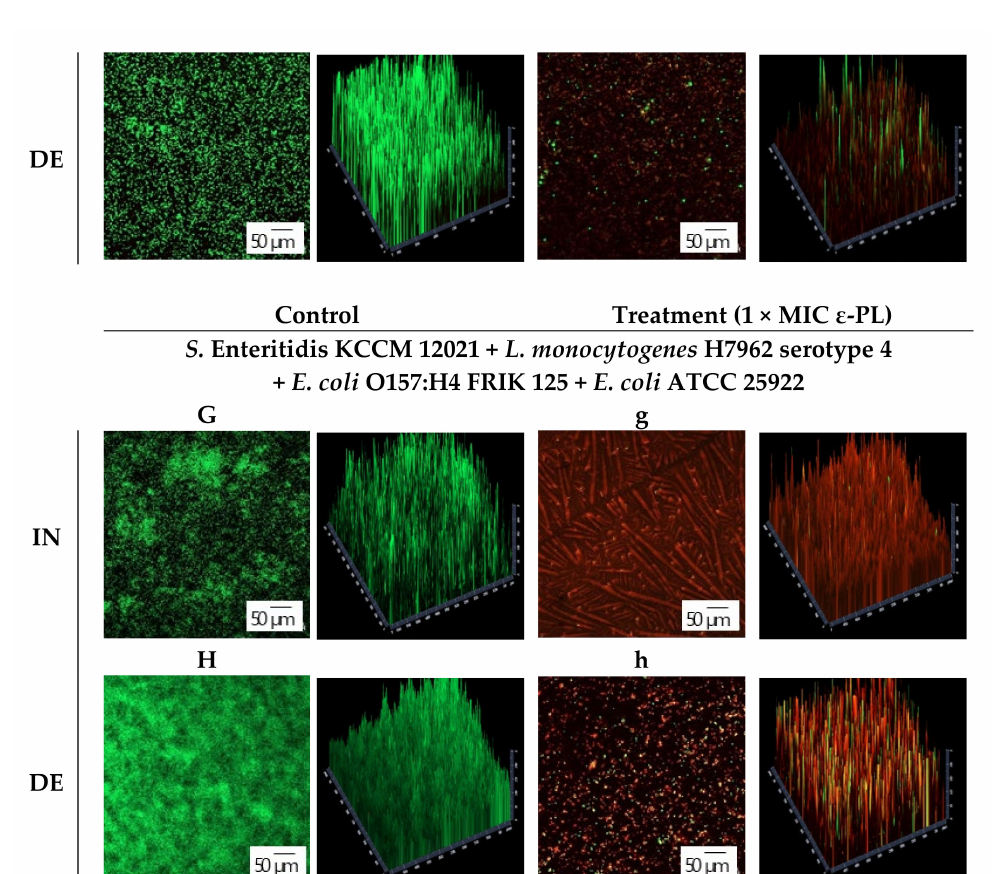
Figure 4. Confocal laser scanning microscopy (CLSM) images of bacterial biofilms cells stained with SYTO 9 (live/green) and PI (dead/red) on glass coupons (100 x magnification). Control and treatment (1 × MIC of ε -PL) are marked in capital letters and small letters, respectively. IN, inhibition of biofilms; DE, degradation of mature biofilms. ( A , a , B , b ) S. Enteritidis KCCM 12021; ( C , c , D , d ) L. monocytogenes H7962 serotype 4; ( E , e , F , f ) E. coli O157:H4 FRIK 125 + E. coli ATCC 25922; ( G , g , H , h ); S . Enteritidis KCCM 12021 + L. monocytogenes H7962 serotype 4 + E. coli O157:H4 FRIK 125 + E. coli ATCC